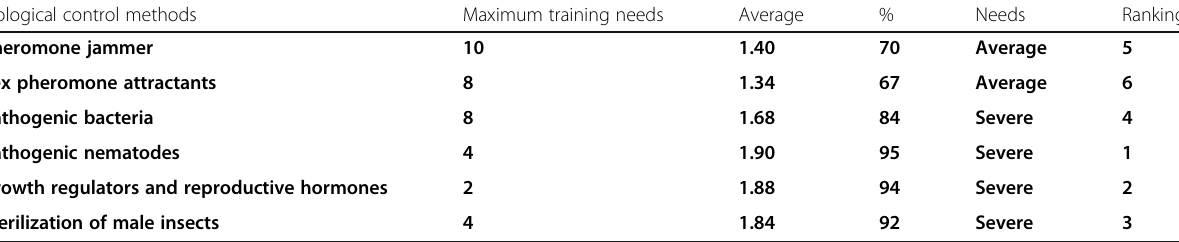
Table 5 Distribution of extension change agents according to their training needs in bio resistance methods Biological control methods